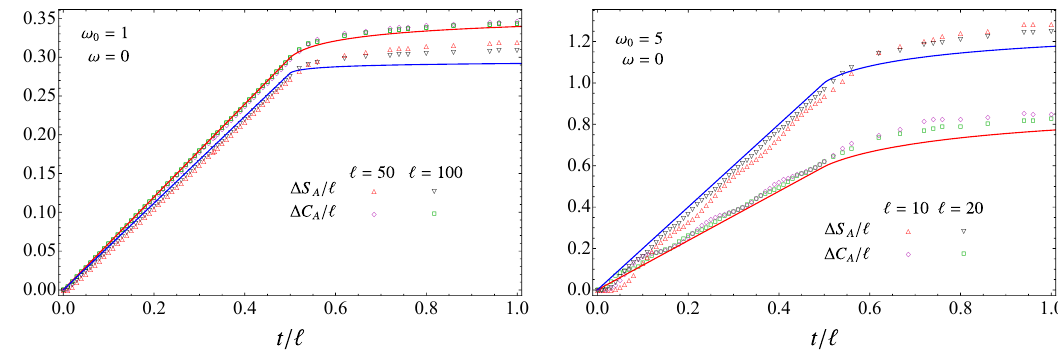
Figure 5 . Temporal evolutions of ∆ S A and ∆ C A of a block made by ‘ consecutive sites in the infinite harmonic chain after a global quantum quench of the mass parameter from ω 0 to ω . In the left panel ω 0 = 1 , while ω 0 = 5 in the right